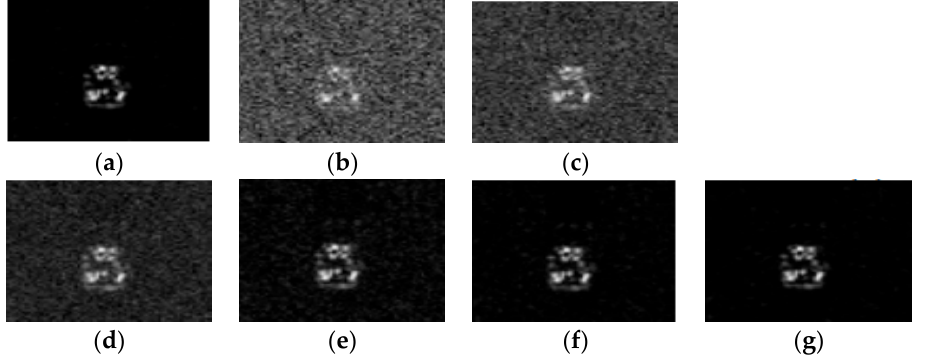
Figure 16. SAR images with different SNRs. ( a ) Original image; ( b ) 0 dB; ( c ) 10 dB; ( d ) 20 dB; ( e ) 30 dB; ( f ) 40 dB; ( g ) 50 dB.